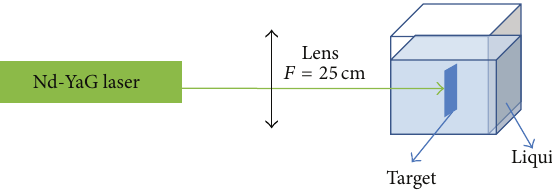
Figure 1: The LA setup for the colloidal NPs production.